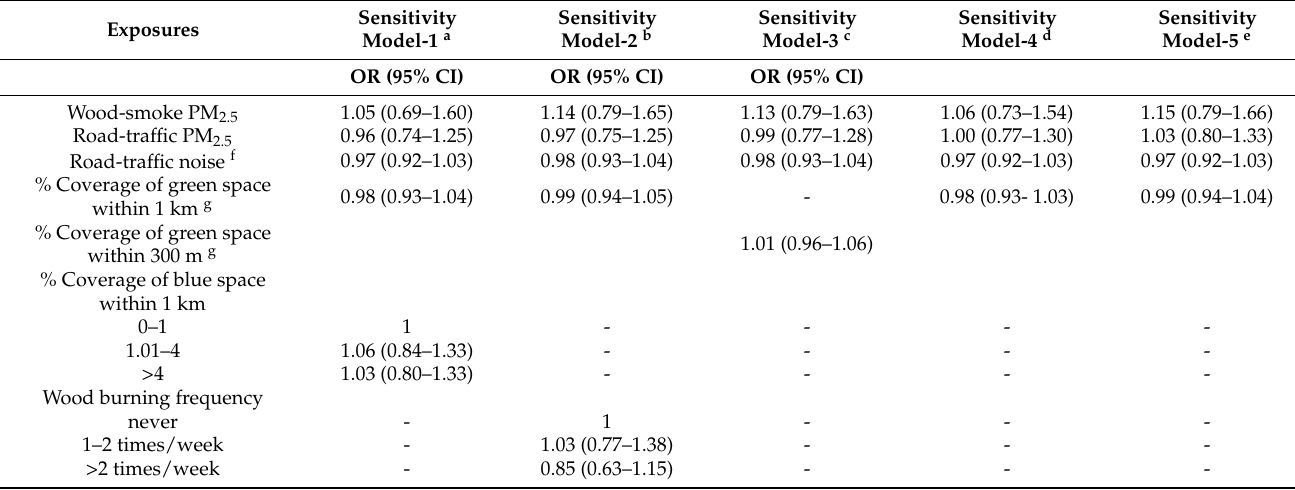
Table 4. Sensitivity models for the associations between environmental exposures and use of antihypertensives.